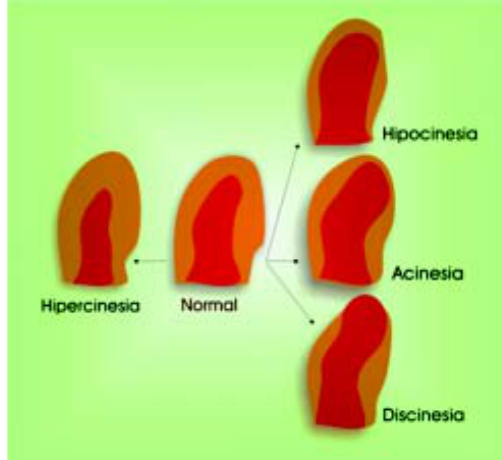
Fig. 1 – Resposta do mocárdio ao estresse